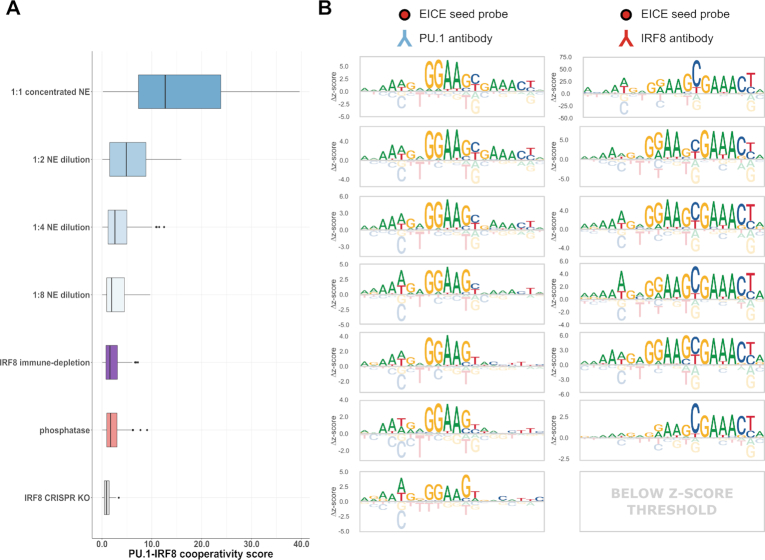
Effects of different nuclear extract treatments on PU.1-IRF8 cooperative binding. (A) Boxplot of PU.1-IRF8 cooperativity scores (see Methods) for a set of EICE probes (n = 116) in various listed nuclear extract (NE) conditions and treatments including a gradient of 2-fold dilutions (1:1, 1:2, 1:4, and 1:8), an extract where IRF8 has been immune-depleted (IRF8 immune-depletion), an extract treated with a broad-spectrum phosphatase (phosphatase), and an extract generated from a line of cells where IRF8 has been knocked out (IRF8 CRISPR KO). Boxplot elements – center line: median, box limits: first and third quartiles, whiskers: 1.5x interquartile range, individual points: data points beyond end of whiskers. (B) Sequence logos obtained by profiling PU.1 binding (left column) and IRF8 binding (right column) to the same sample EICE seed probe in the corresponding nuclear extract treatments/conditions from (A).